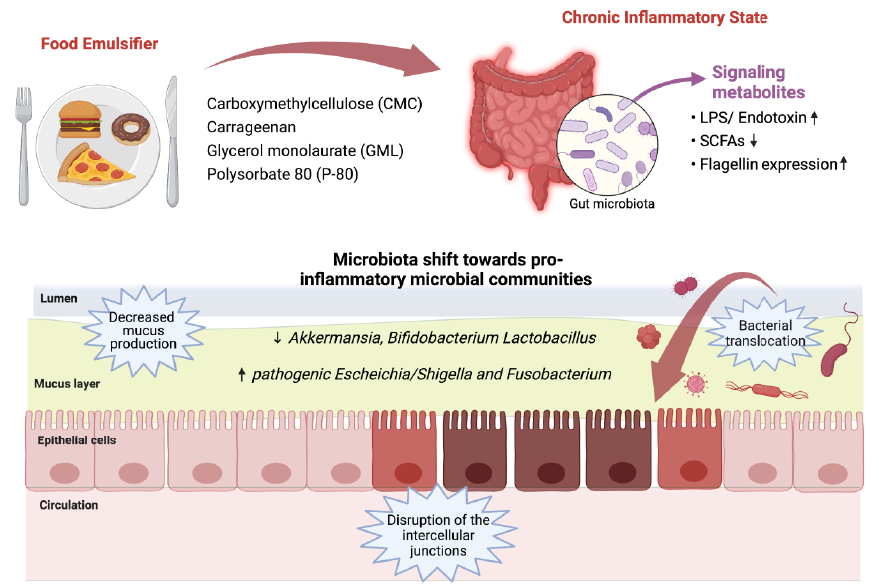
Figure 1. The impact of some common food emulsifiers on gut microbiota and intestinal barrier. Abbreviations: LPS, lipopolysaccharide; SCFAs, short-chain fatty acids; ↓ decrease; ↑ increase .